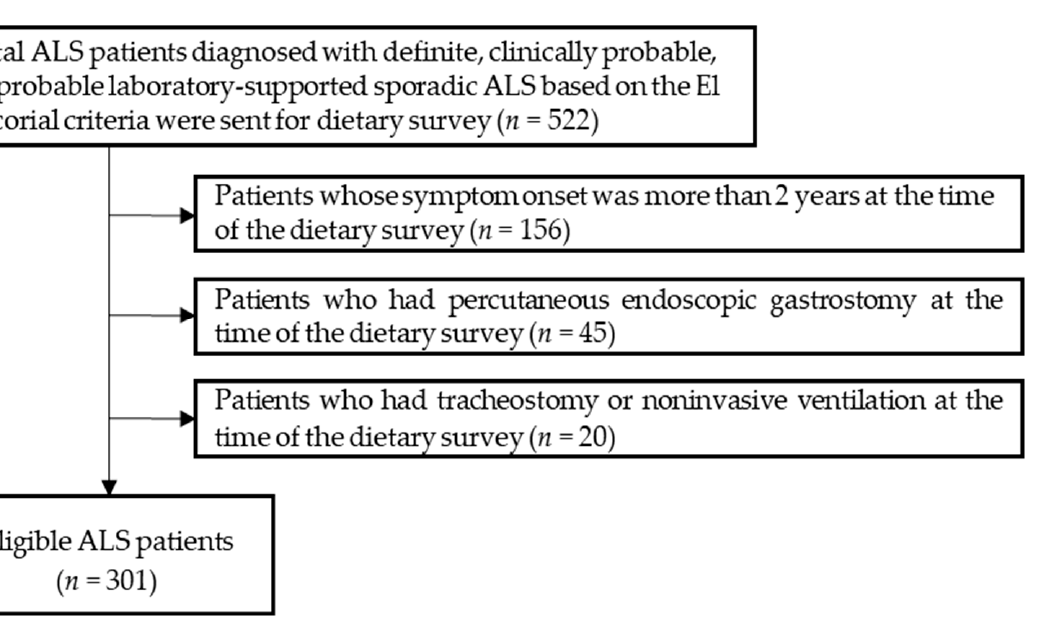
Figure 1. Flow chart for the selection of participants with amyotrophic lateral sclerosis (ALS).